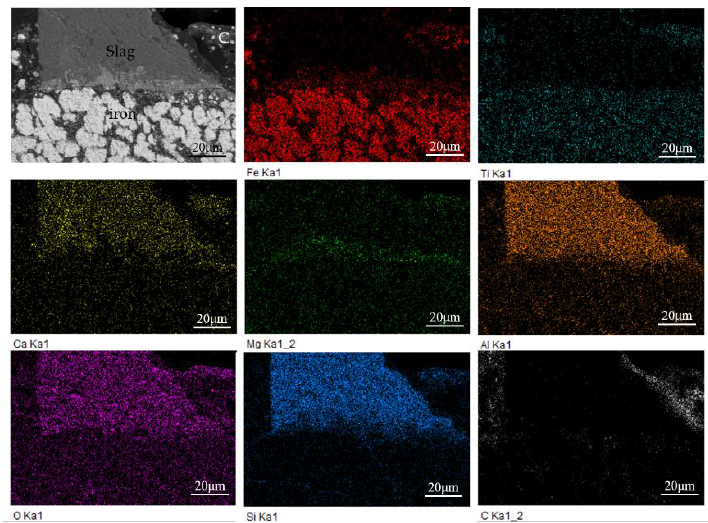
Figure 9. EDS elemental mapping of the reduced sample at 1000 °C.